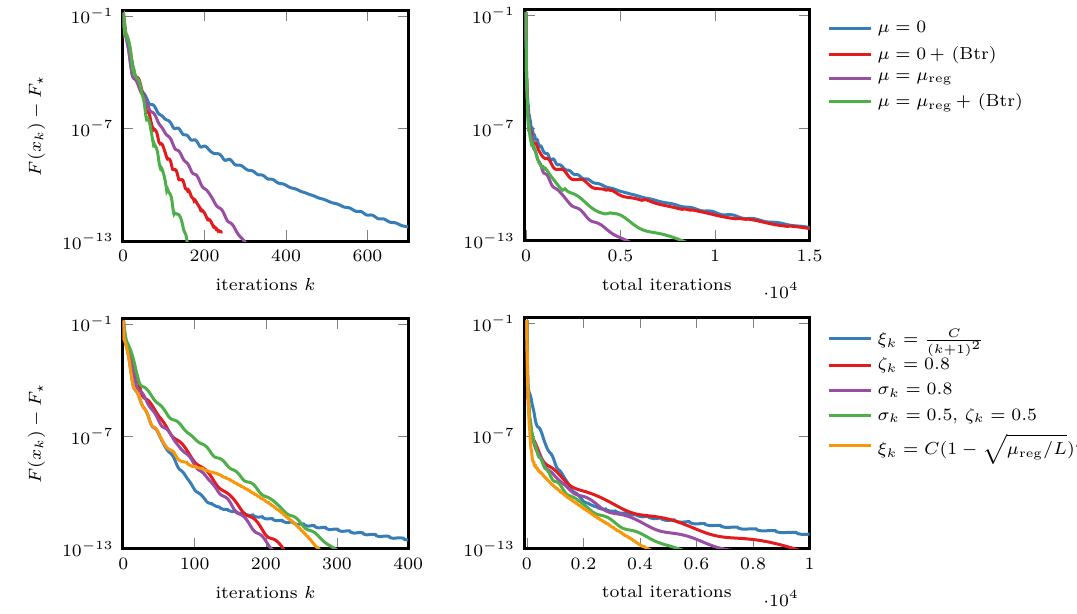
2 , initial L to 0 L